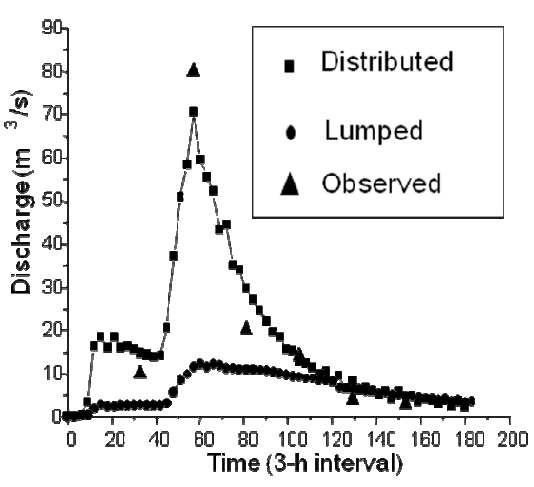
Figure 2. Simulated runoff hydrograph for the rainfall event on 21-6-96